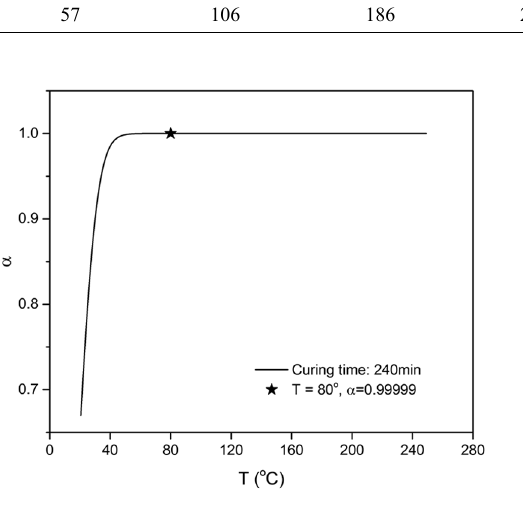
Table 1. Kinetic parameters obtained from the dynamic DSC preliminary run for the Araldite ® LY5052/Aradur5052 TM epoxy system. T (°C) onset